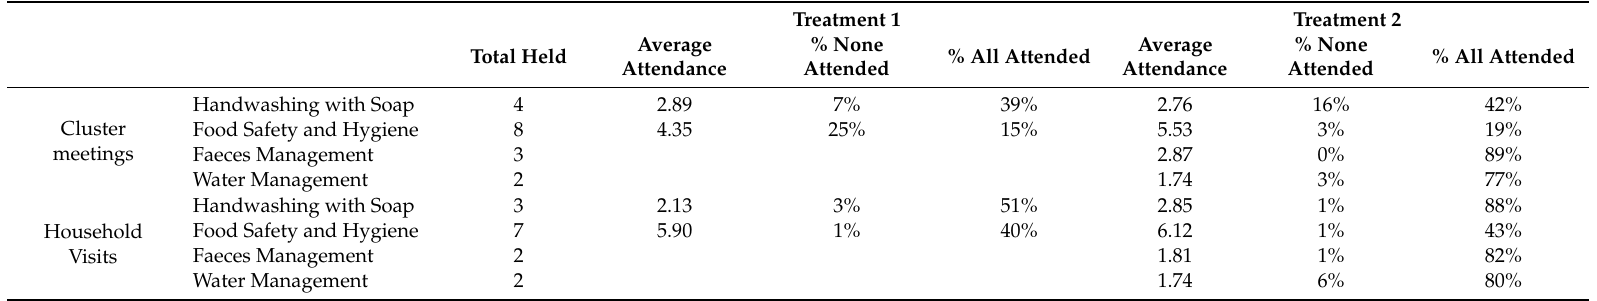
Table 4. Attendance at cluster meetings and participation in household